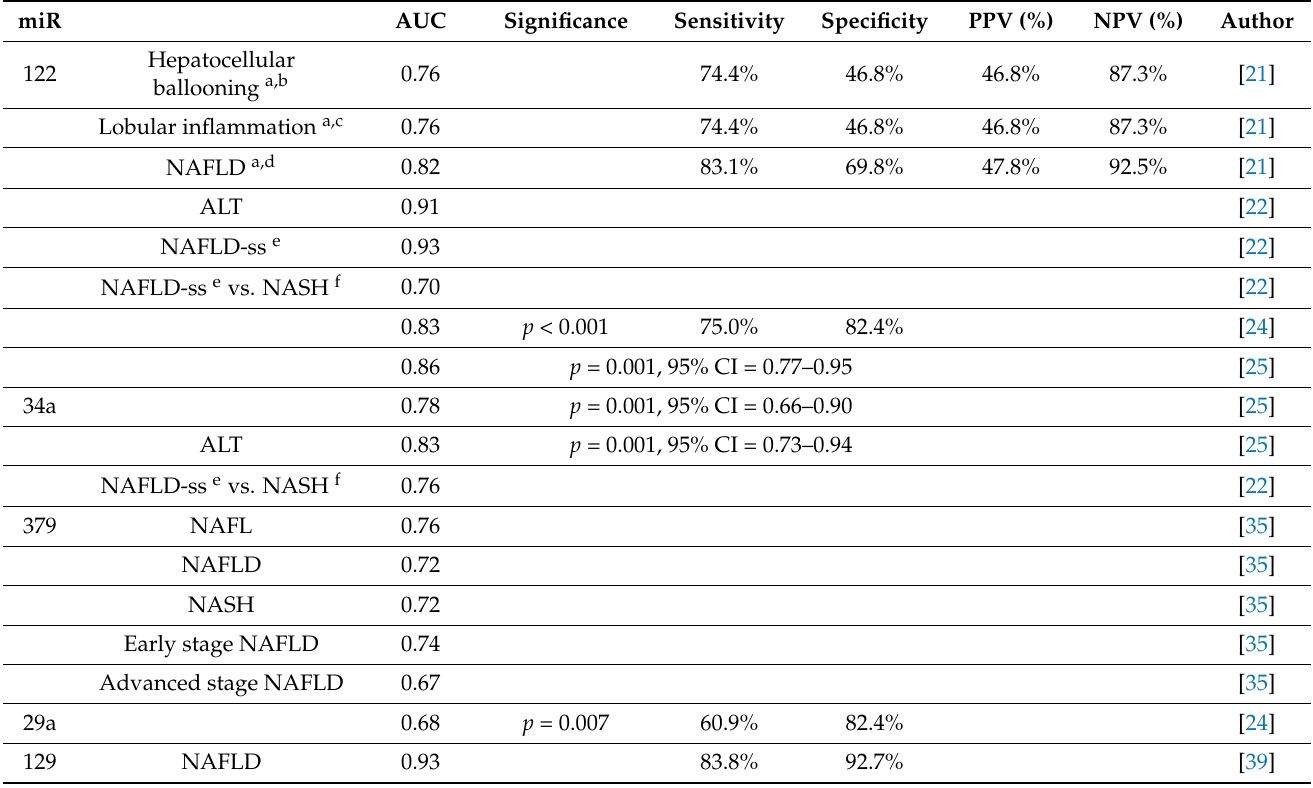
Table 3. Receiver Operation